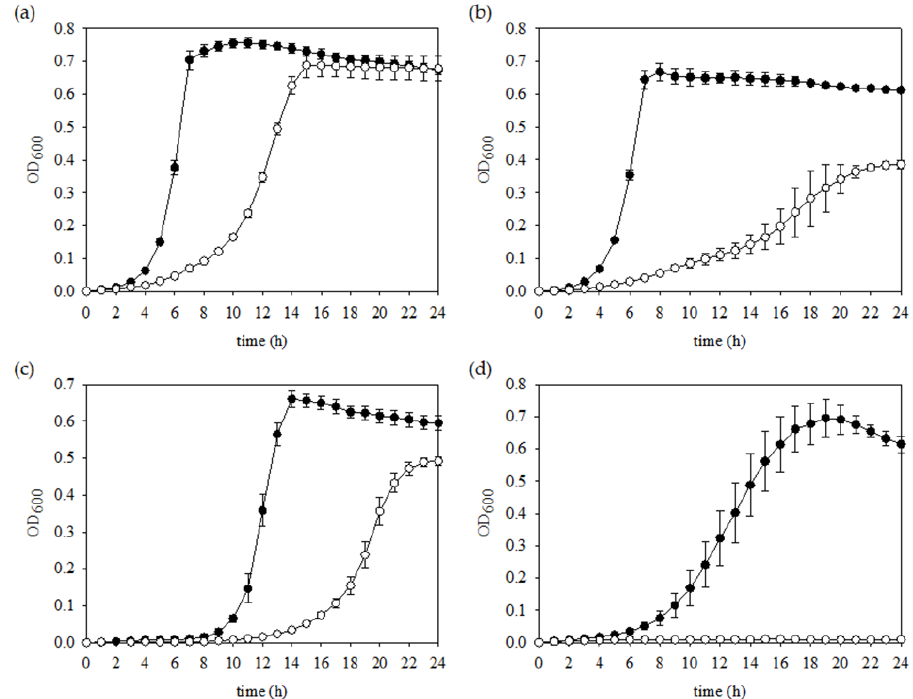
Figure 2. Growth phenotypes of S. mutans wild-type and FR strains under various stress conditions. Cells were grown in triplicate to mid-exponential phase in BHI medium and diluted 1:100 into fresh BHI medium ( a ) with a mineral oil overlay, ( b ) without a mineral oil overlay, ( c ) supplemented with 0.003% H 2 O 2 , or ( d ) supplemented with HCl to lower the pH to 5.5 in anaerobic conditions. The symbols (closed and open circles) indicate S. mutans wild-type and FR strains, respectively.